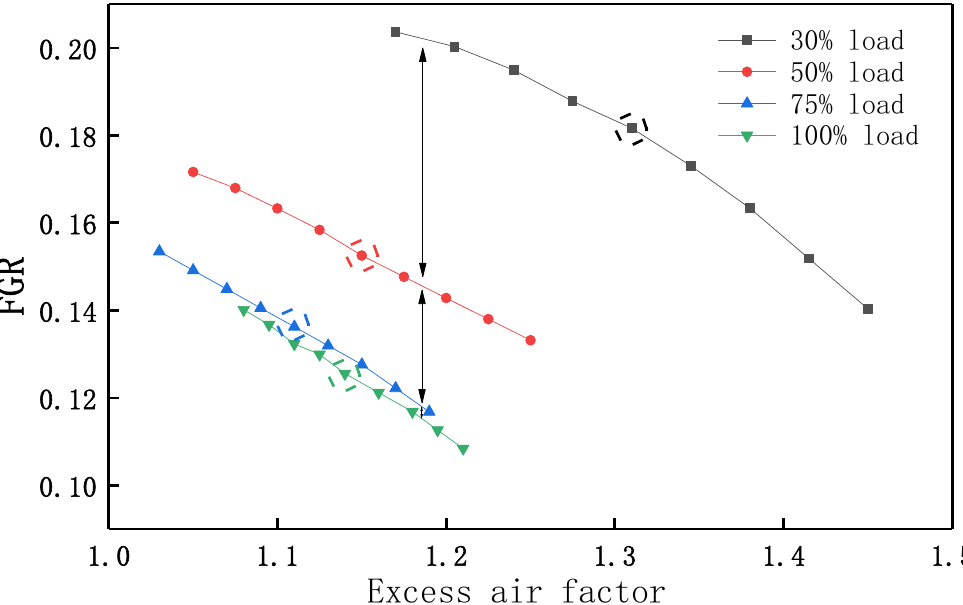
Figure 10. Influence of excess air factor on FGR under different loads of reference system.